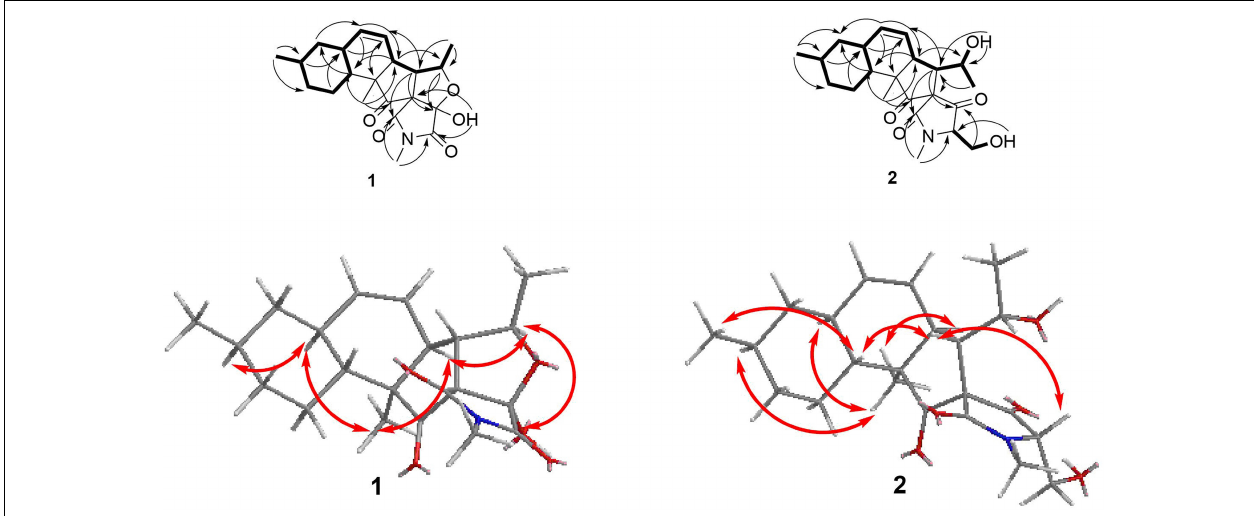
FIGURE 2 | COSY, key HMBC, and NOESY correlations of 1 and 2